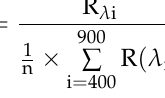
Table 1. The chlorophyll-a (Chl-a! retrieval models and the bands.